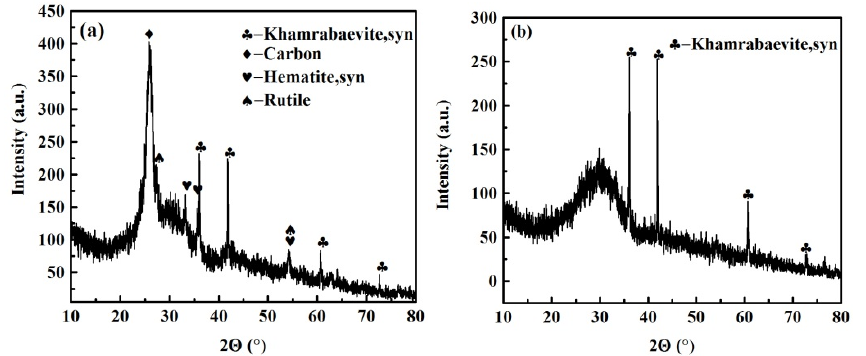
Figure 5. XRD patterns of flotation products were obtained under the optimized conditions. ( a ) OPFC samples and ( b ) OPFT samples.